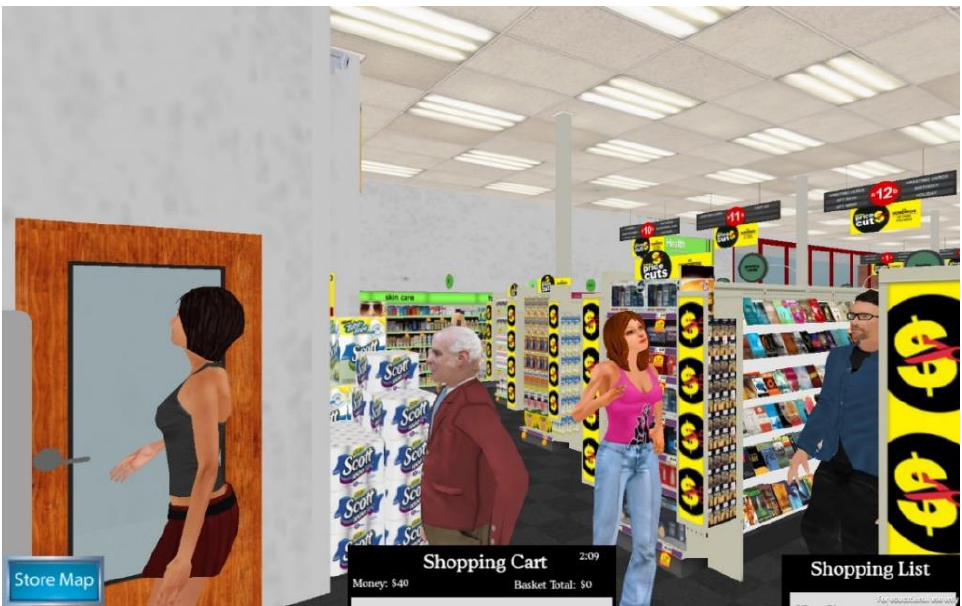
Figure 2. Everyday distractors in the Virtual Environment Grocery Store.